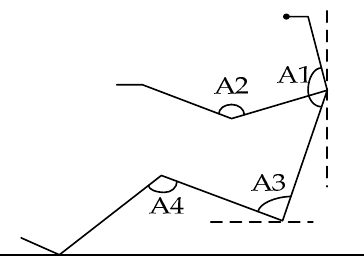
Figure 6. Postural angle model.